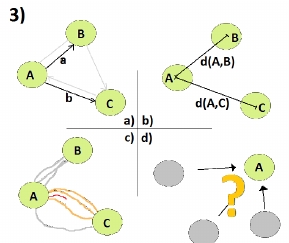
Figure 6: The probability depends on four factors: (a) preferred destination of other individuals, (b) distance to possible destina- tions, (c) similarities concerning shape and parameters of the cur- rent to other way segments, (d) already passed